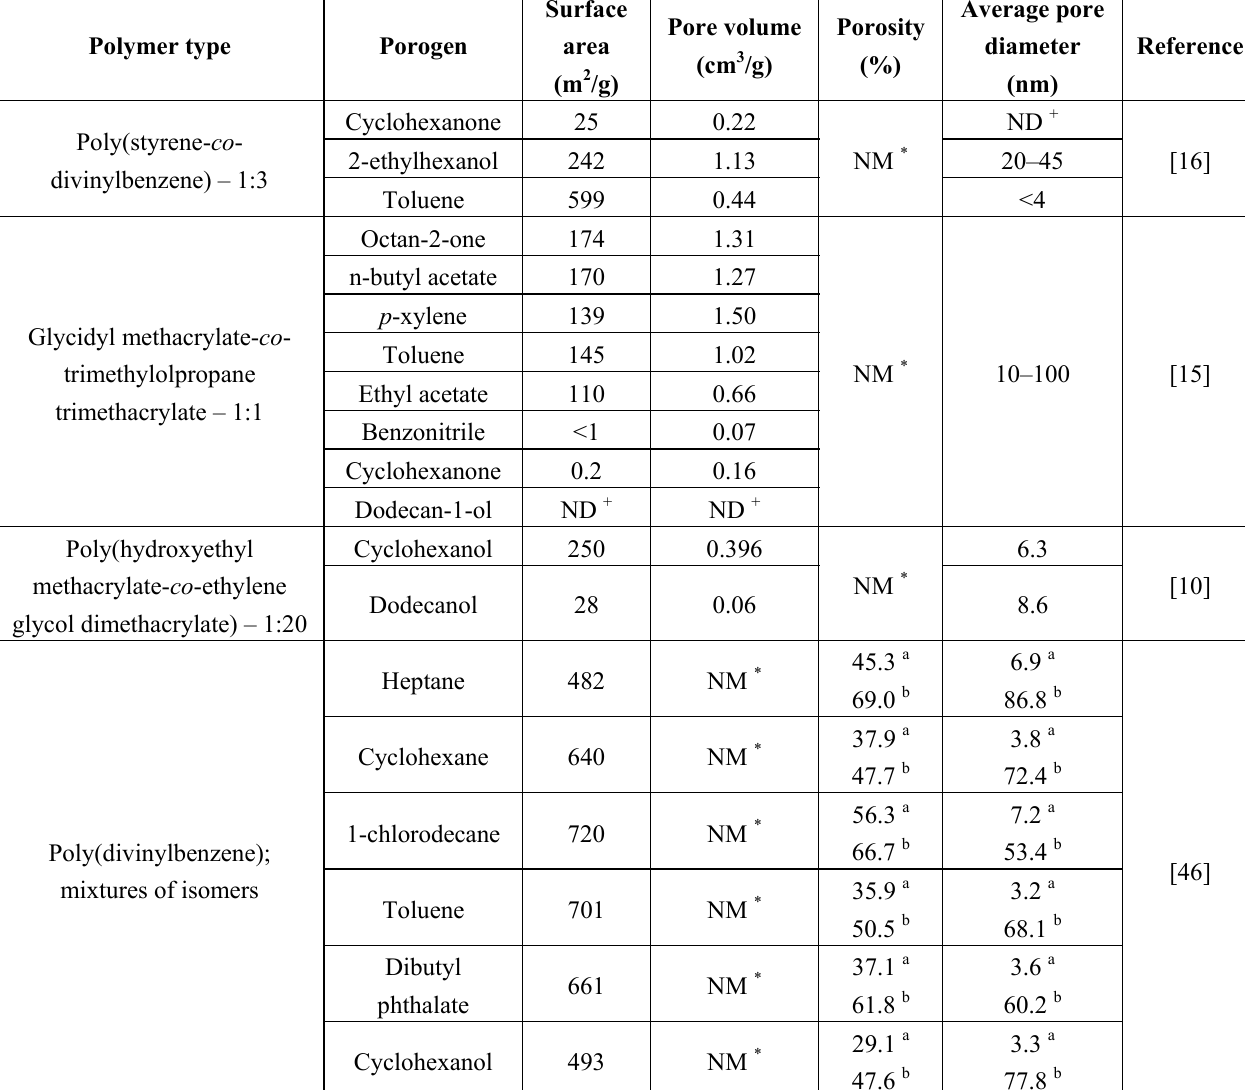
Table 1. Surface area (from nitrogen porosimetry), pore-volume, pore-size and average pore diameter of porous copolymer resin (PCR) synthesized in presence of different types of solvent porogens. The synthesis properties are the same as indicated in Section